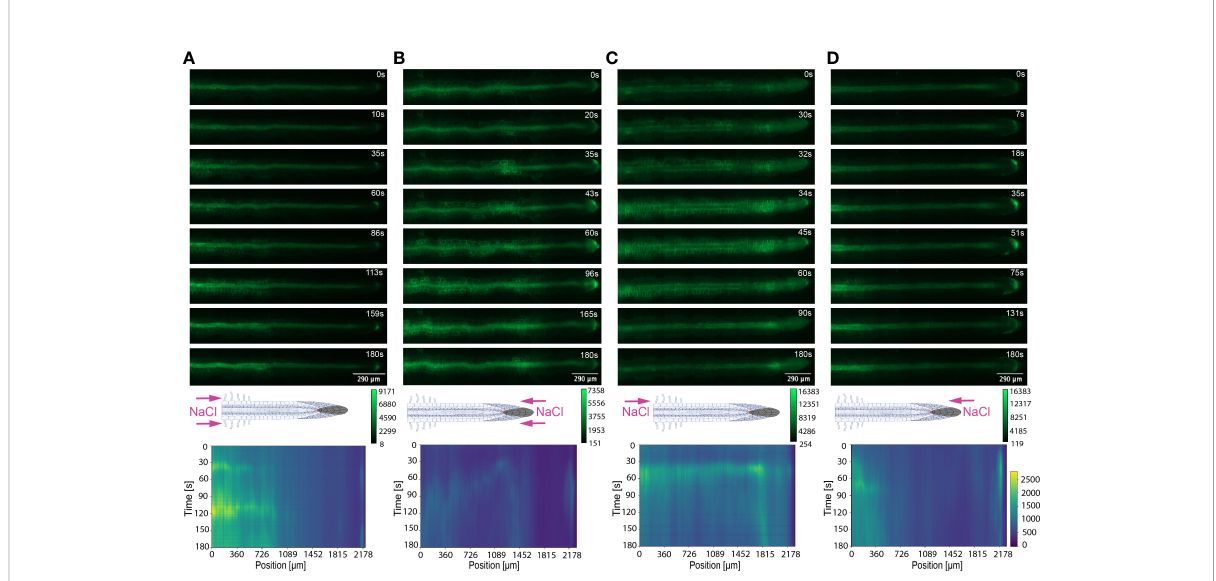
FIGURE 4 Key Ca 2+ signal localisation in Arabidopsis roots exposed to 100 mM NaCl. Schematic diagrams depict treatment localisation and orientation at the root within the bi-dfRC with fl uorescent intensity calibration bars. Kymographs depict the spatial fl uorescense of GFP corresponding to Ca 2+ in the root over time, in dependence of treatment orientation and localisation. GFP fl uorescence in kymographs is color coded, ranging from dark blue to yellow (normalized for all samples). (A) Key Ca 2+ localisation pattern upon NaCl treatment through inlets A & B of the bi-dfRC at the differentiation zone. (B) Key Ca 2+ localisation pattern upon NaCl treatment through inlets C & D of the bi-dfRC at the tip. (C) Key Ca 2+ localisation pattern upon NaCl treatment through inlet B (top) and control treatment through inlet A (base) of the bi-dfRC at the differentiation zone. (D) Key Ca 2+ localisation pattern upon NaCl treatment through inlet D (top) and control treatment through inlet C (base) of the bi-dfRC at the